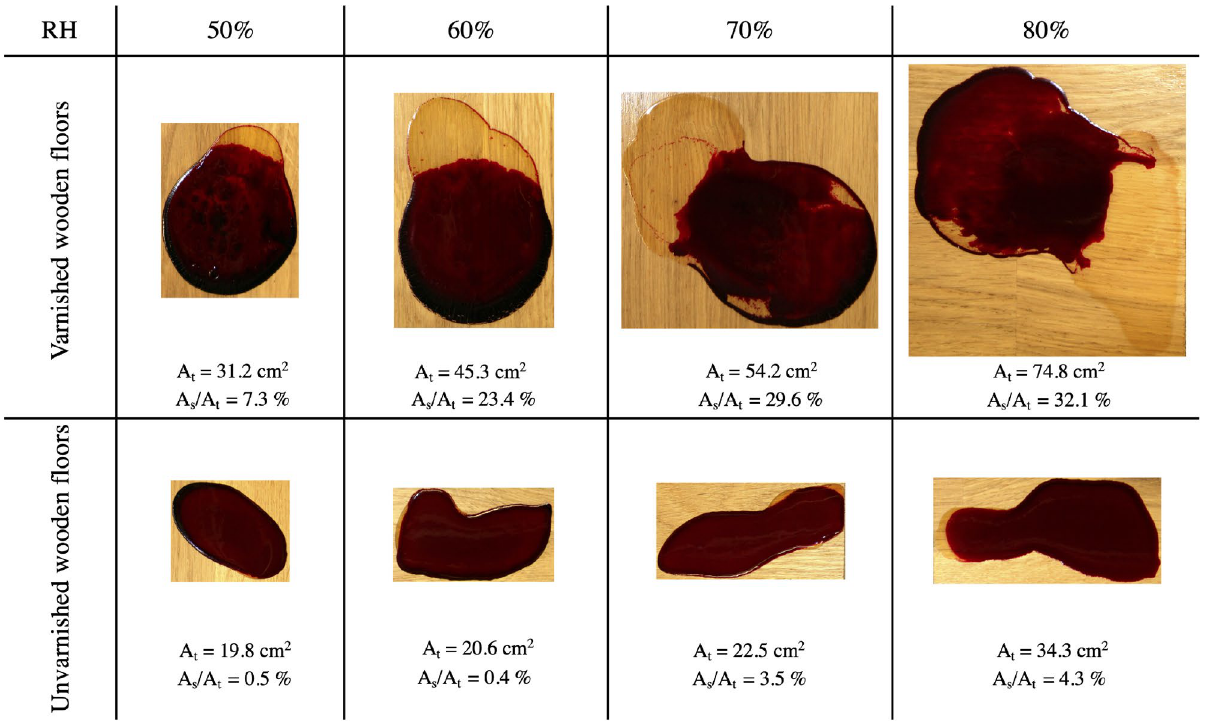
Figure 7. Effect of relative humidity and substrates on the spreading and phase separation of blood pools ( m i = 4.82 g ± 0.5% , hct = 42.8% ± 2.6% ). Pools created on varnished and unvarnished wooden floors at 21 ◦ C with relative humidities ranging from 50% to 80% . A t denotes the total area of the pool and A s / A t denotes the ratio between the serum area and the total pool